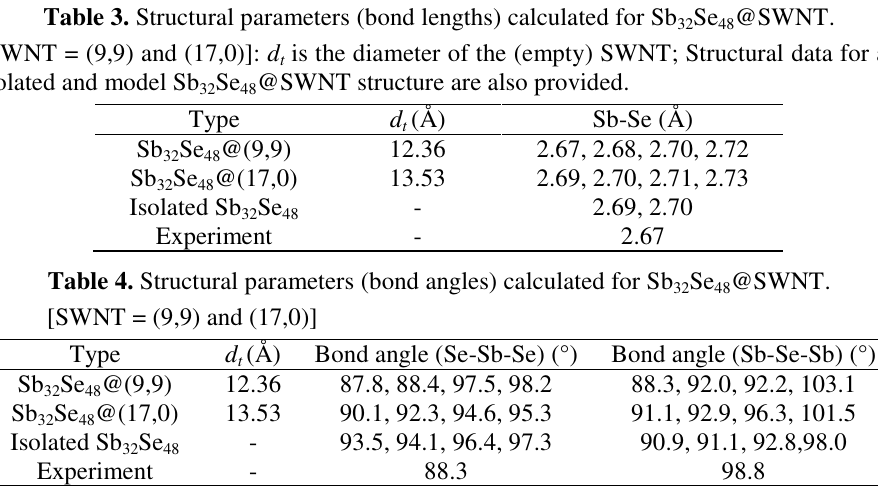
Se @ (9,9) (b). Sb Se @ (17,0). 32 48 32 48 Se crystals in the structural 32 48 Se crystal are 32 48 Se @SWNT. 32 48